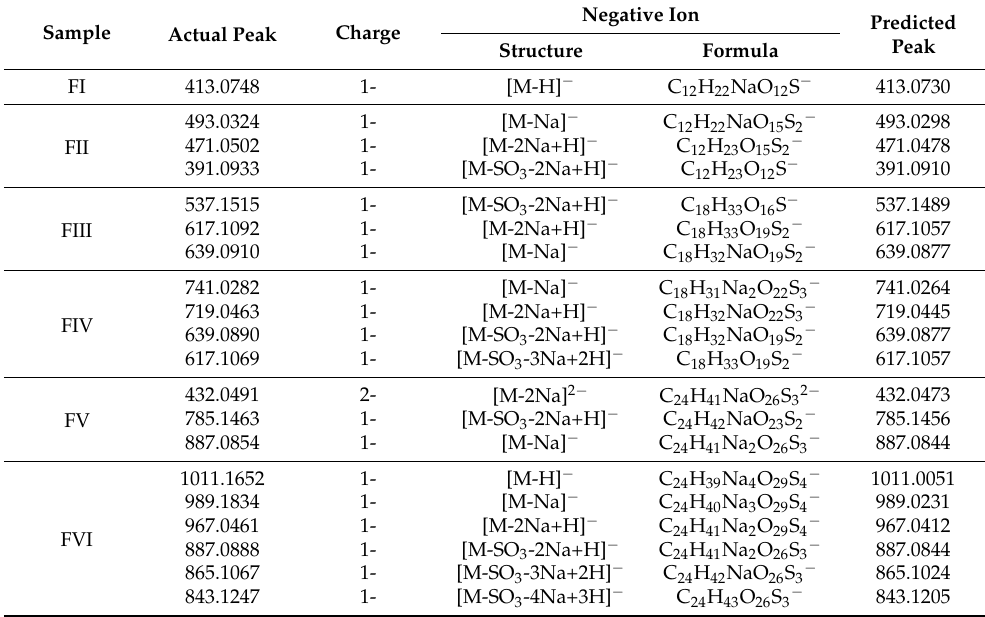
Table 4. Electrospray ionization mass spectrometry (ESI-MS) data assignments of